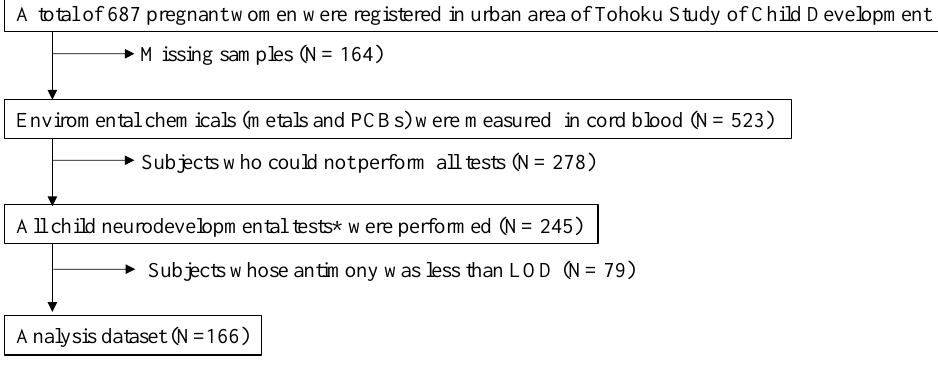
Figure 1. Flowchart of the study subjects. * NBAS, BSID-II, K-ABC, and WISC-III. LOD, limit of detection.